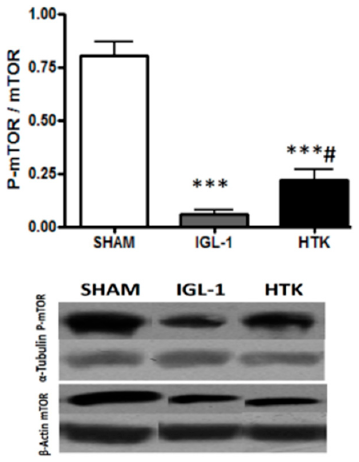
Figure 3. p-mTOR/mTOR expression in fatty liver grafts preserved in HTK or IGL-1 solutions. The ratio of p-mTOR to total mTOR was quantified by densitometry based on immunoblot images. Bar graphs represent the mean ± SD. *** p < 0.0005 vs. SHAM, # p < 0.05 vs. IGL-1.